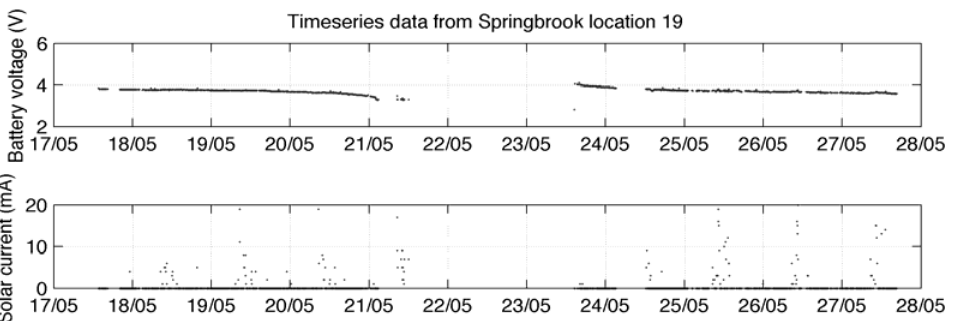
Figure 10. Solar current and battery voltage in low sunlight